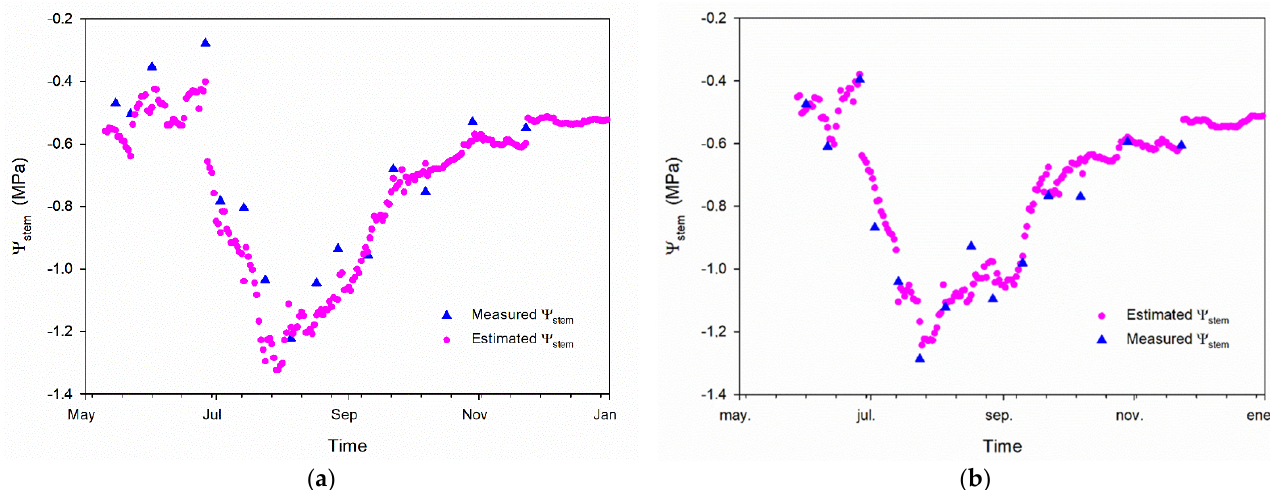
Figure 6. Predictions of Ψ stem obtained with the RF regression model trained with Configuration 2 and T = 10 days and measured Ψ stem in FMR ( a ) and RDC-2 ( b ) irrigation treatments during 2015.